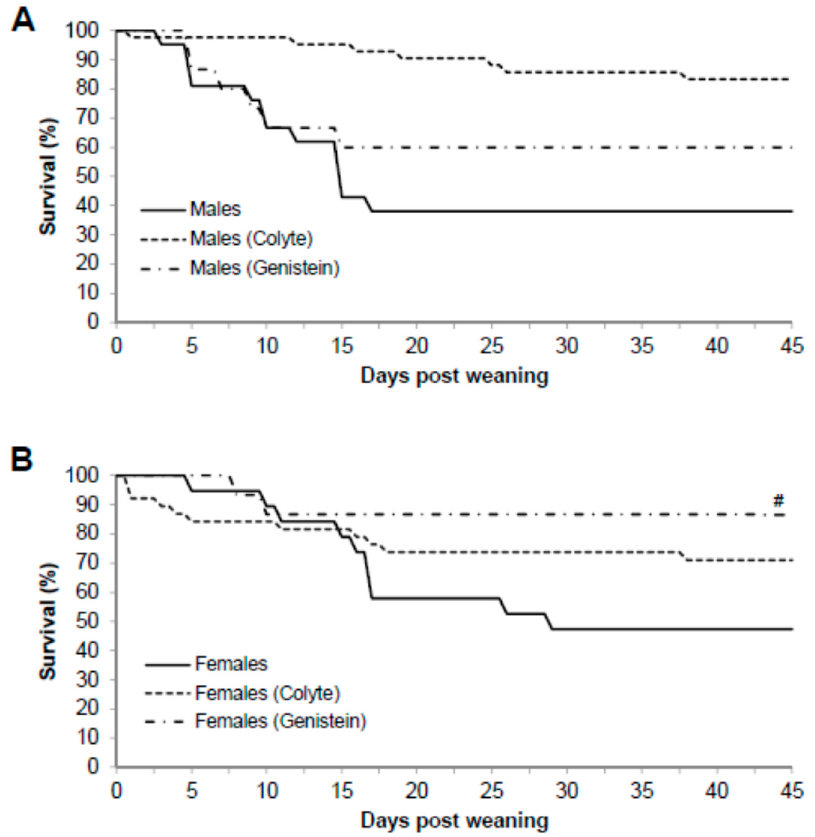
Figure 2. Effect of dietary genistein on survival rates of ∆ F508-CF mice. Differing diets were started at weaning (aged 20 days), monitored up to age 65 days. ( A ) The percentage of males surviving with each diet were; standard diet (38%), colyte diet (83%) and genistein diet (60%). ( B ) The percentage of females surviving with each diet were; standard diet (47%), colyte diet (71%), and genistein diet (87%). Data are mean. # indicates significant genistein-mediated difference compared to controls, p < 0.05.